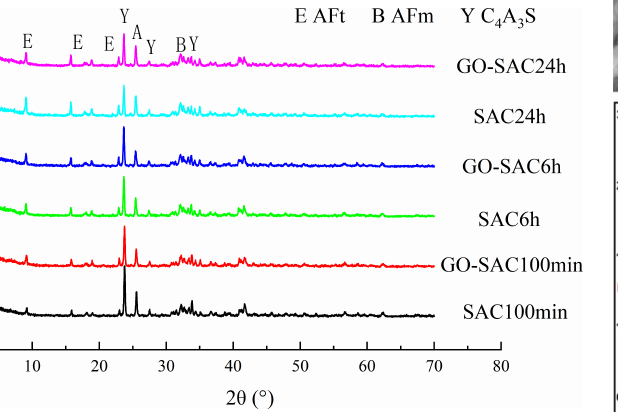
Figure 2: XRD patterns of SAC and GO-SAC at the ages of 100 min, 6 h and 24 h